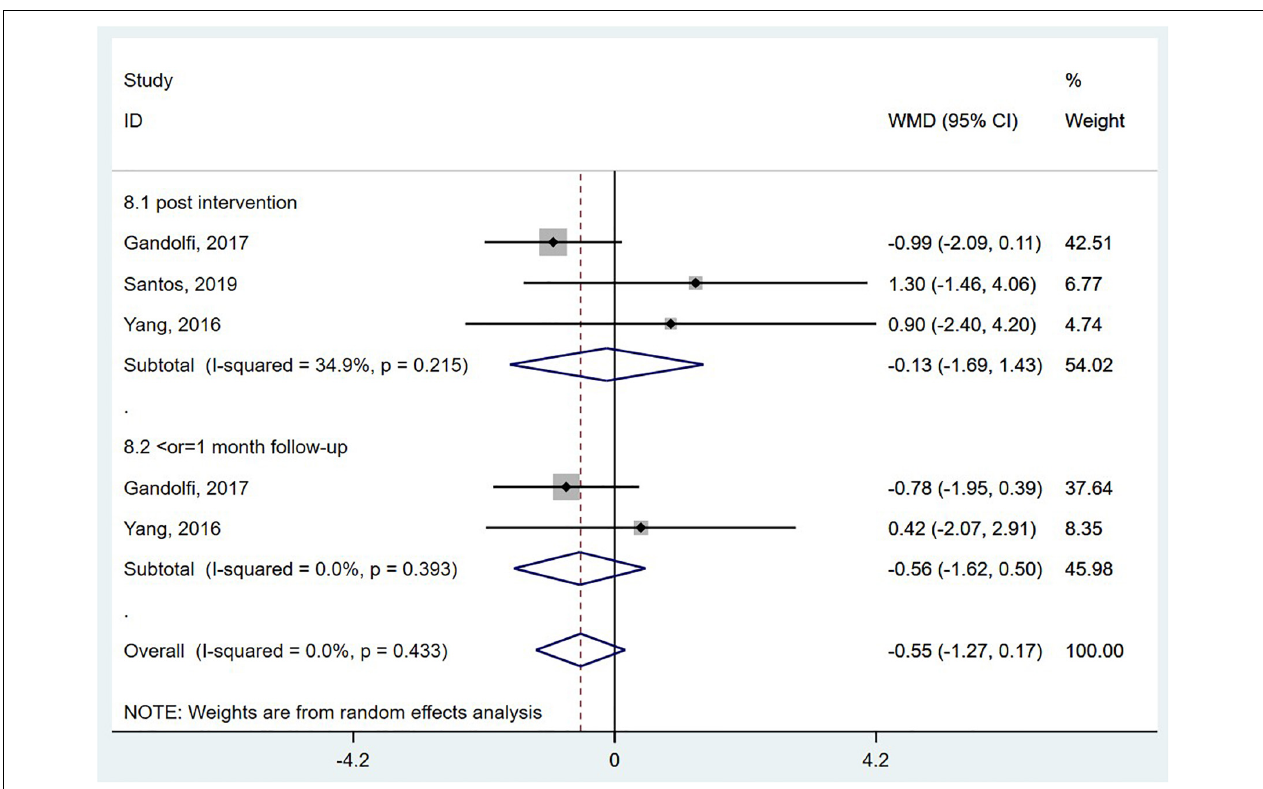
FIGURE 8 | Forest plot of pooled results for dynamic gait